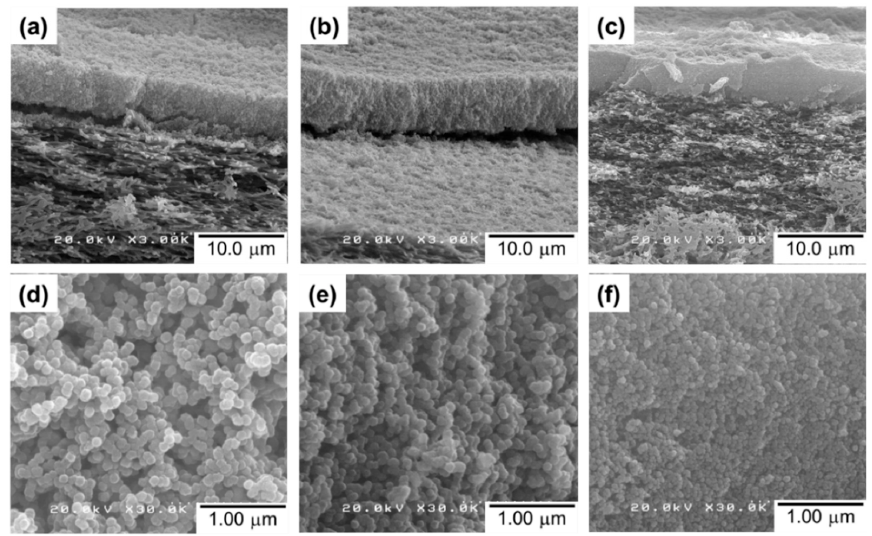
Figure 4. Cross-sectional SEM images of the composite membranes: ( a , d ) UiO5; ( b , e ) UiO4; ( c , f ) UiO2 at different magnifications.